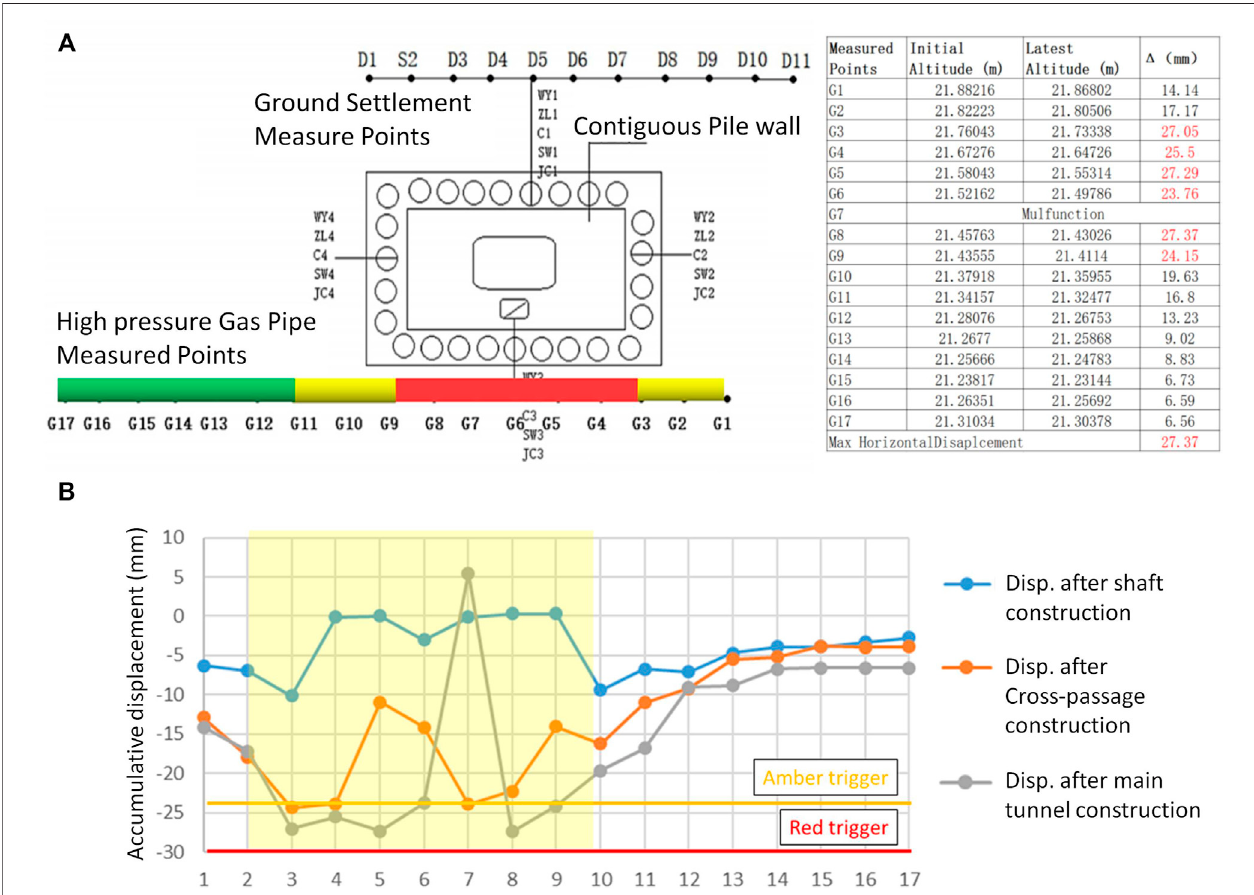
FIGURE 7 | Ground surface settlement data from gas pipe monitoring: (A) latest results dated June 30, 2019; (B) change of gas pipe monitoring data over construction period (G7 malfunctioned after grouting).